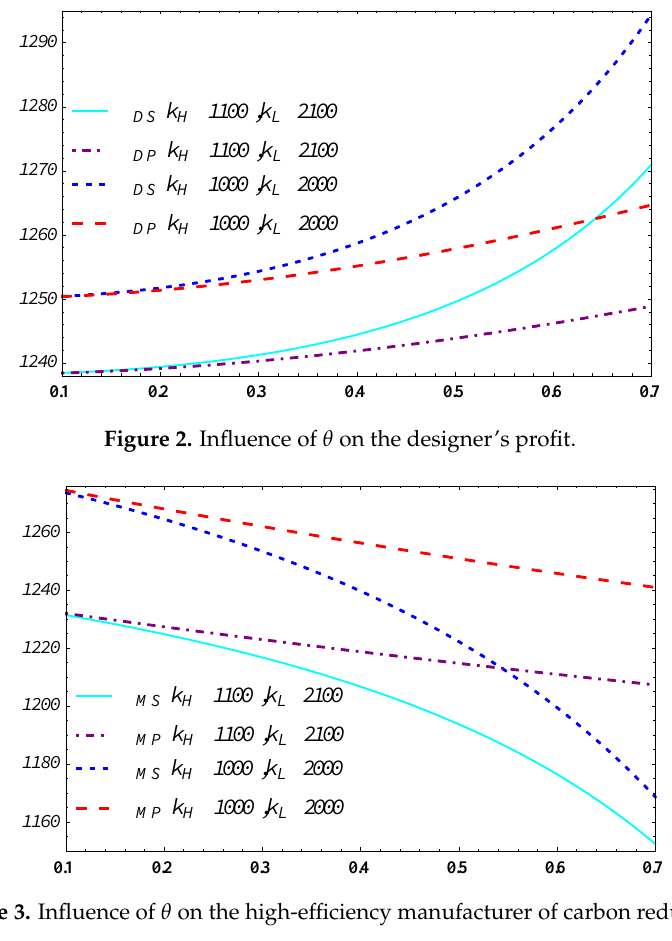
Figure 4. Influence of